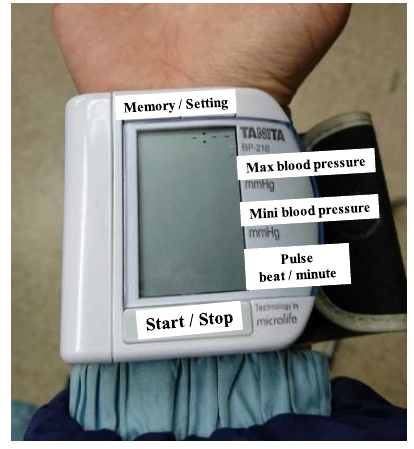
Figure 8. Photograph of heart rate meter.